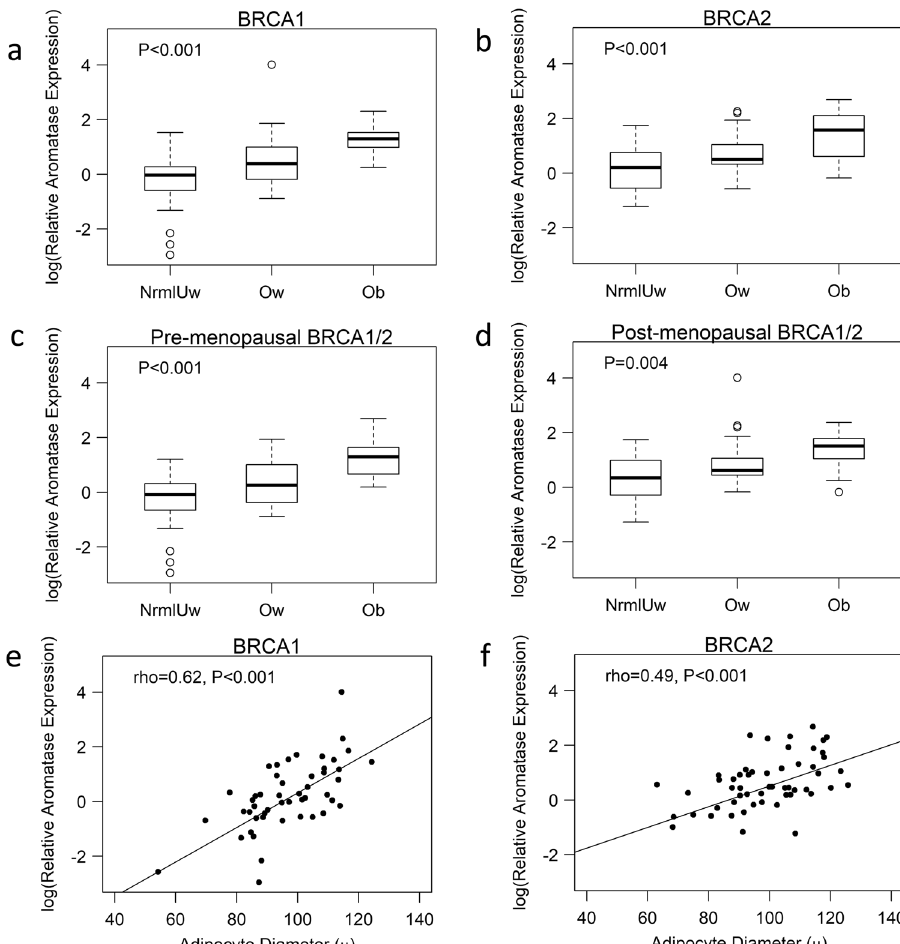
carriers. c Relative aromatase expression by BMI category in pre-menopausal BRCA1/2 mutation carriers. d Relative aromatase expression by BMI category in post-menopausal BRCA1/2 mutation carriers. Box boundaries represent upper and lower quartiles, centerline represents median, whiskers represent data points within 1.5× interquartile range from the box, and circles represent data points lying beyond the extremes of the whiskers. e Relative aromatase expression by adipocyte diameter in BRCA1 mutation carriers. f Relative aromatase expression by adipocyte diameter in BRCA2 mutation